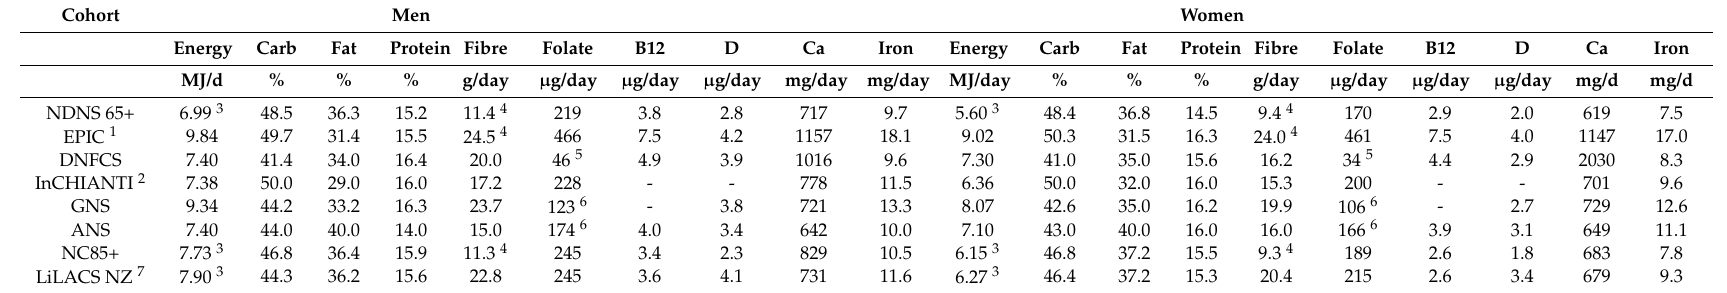
Table 2. Energy and nutrient intake in European and European descendent older adults aged ≥ 80 and ≥ 85 1 .